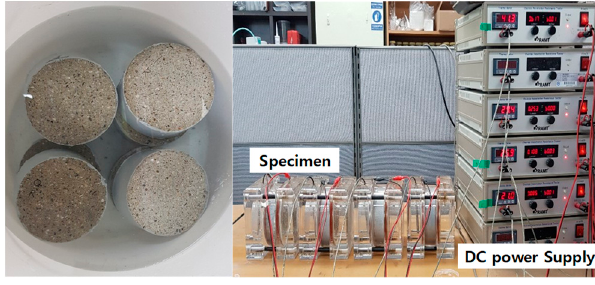
Figure 5. Specimen setup and measurement of resistance chloride ion penetration test specimen setup.